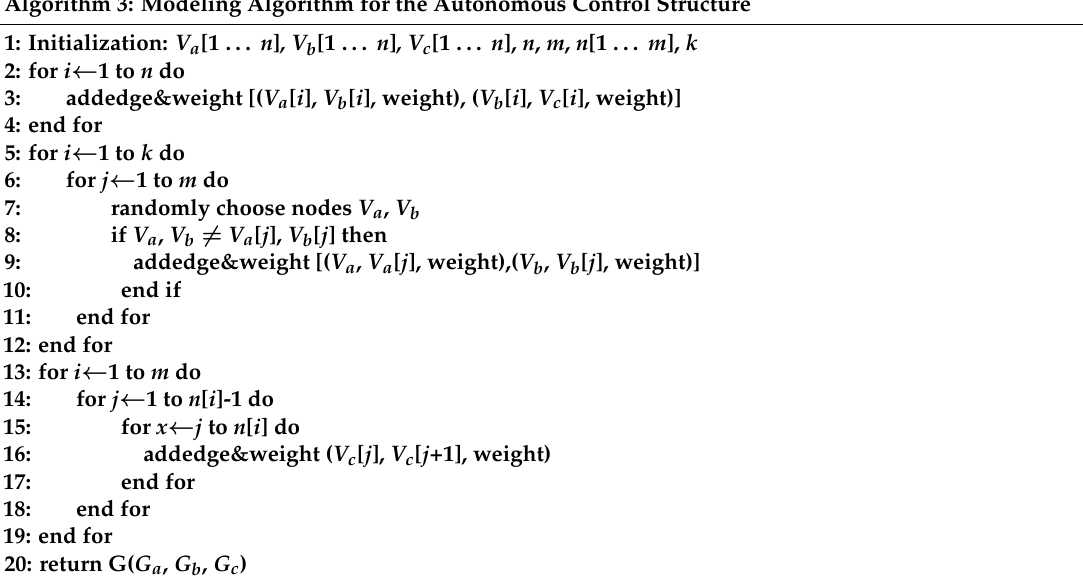
Table 3. Modeling algorithm for Structure 3. Algorithm 3: Modeling Algorithm for the Autonomous Control